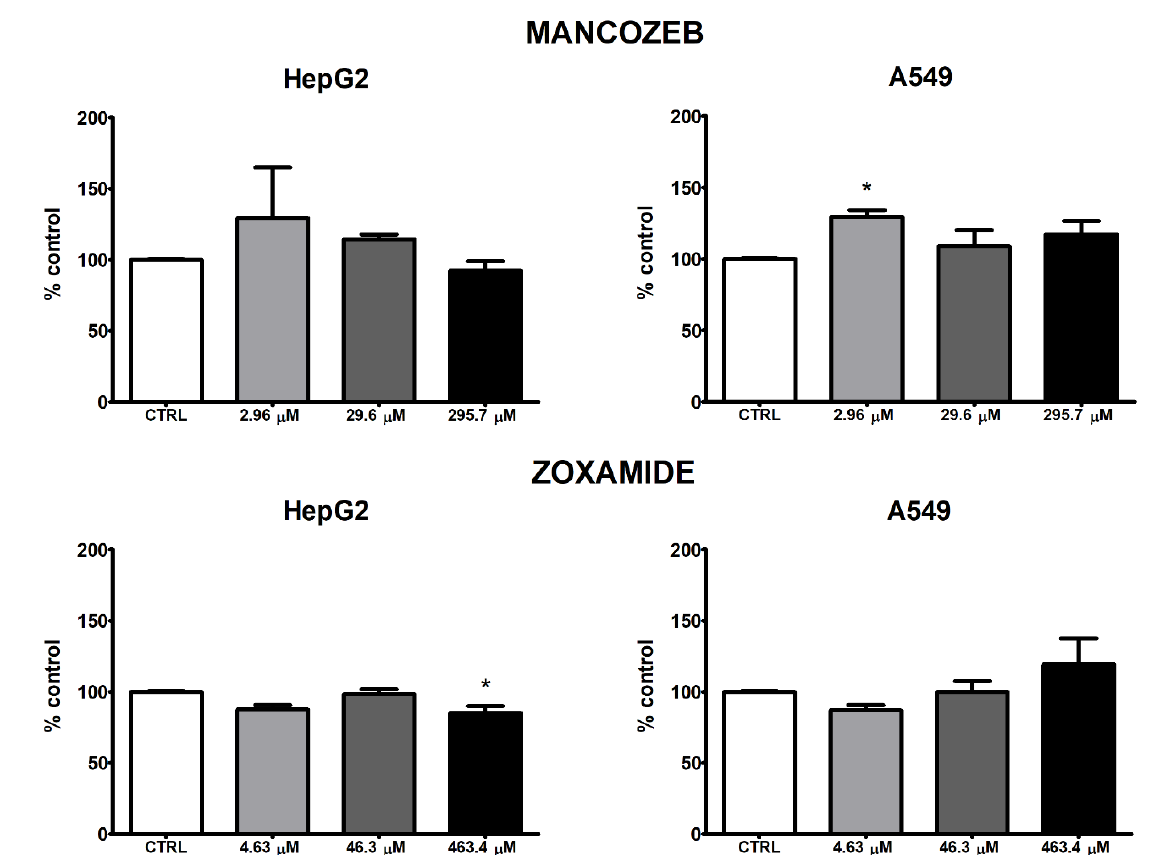
Figure 4. ROS production in HepG2 and A549 cells treated with MZ and ZOX for 24 h. Values are means ± SEM of three independent experiments, normalized to the solvent control (0.8% DMSO for MZ; 0.2% DMSO for ZOX) set at 100%. Statistical significance is indicated by asterisks: * p < 0.05.